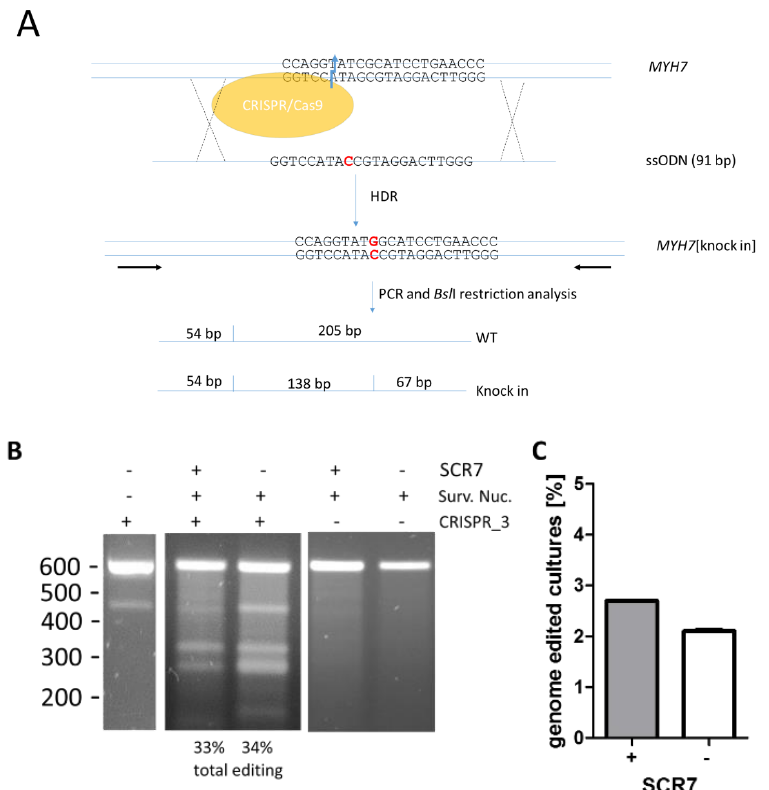
Figure 2. Effect of SCR7 on genome editing of the MYH7 gene. ( A ) Schematic of the experimental setup. Porcine fetal fibroblasts were transfected with vector pX330 that encodes for hCas9 and the sgRNA CRISPR_3 (target site is indicated on the MYH7 -gene) and a 91 bp single-stranded oligodeoxynucleotide (ssODN) representing the non-coding strand and the point mutation (indicated in red) at position 46. This point mutation generates an additional restriction site for BslI. In a PCR-based screening assay for successful genome editing, this restriction site generates a mutation specific 138 bp fragment which can be separated from the wildtype specific 205 bp fragment; ( B ) fibroblasts were transfected with the CRISPR/Cas9 vector pX330_723_3 (CRISPR_3 +) or without vector DNA (CRISPR_3 − ) and were either treated with 1 µM SCR7 for 24 h post transfection (+ SCR7) or left untreated ( − SCR7). To determine the total editing rate, a surveyor nuclease assay was performed. Fibroblasts without CRISPR/Cas9 vectors do not show mismatch-derived restriction bands of the expected size of 328 bp and 270 bp that are detected in CRISPR/Cas9-transfected cells. The total editing rates as the percentage of the normalized IOD of the 328 bp from the 604 bp bands for this specific experiment are given below the gel. The band at appr. 450 bp originates from the PCR (lane 1); ( C ) SCR7-treated and untreated cultures starting from 5 fibroblasts per well of 96-well plates were screened for knock-in of the point mutation c. 2167C > G by PCR and mutation specific restriction analysis. Percentages of cultures with at least one allele containing knock-in are depicted ( n = 2 independent